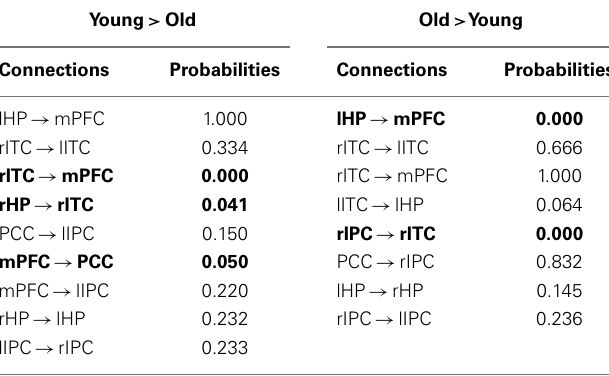
Table 3 |The probabilities ofType-I errors for between-group differences in all connections